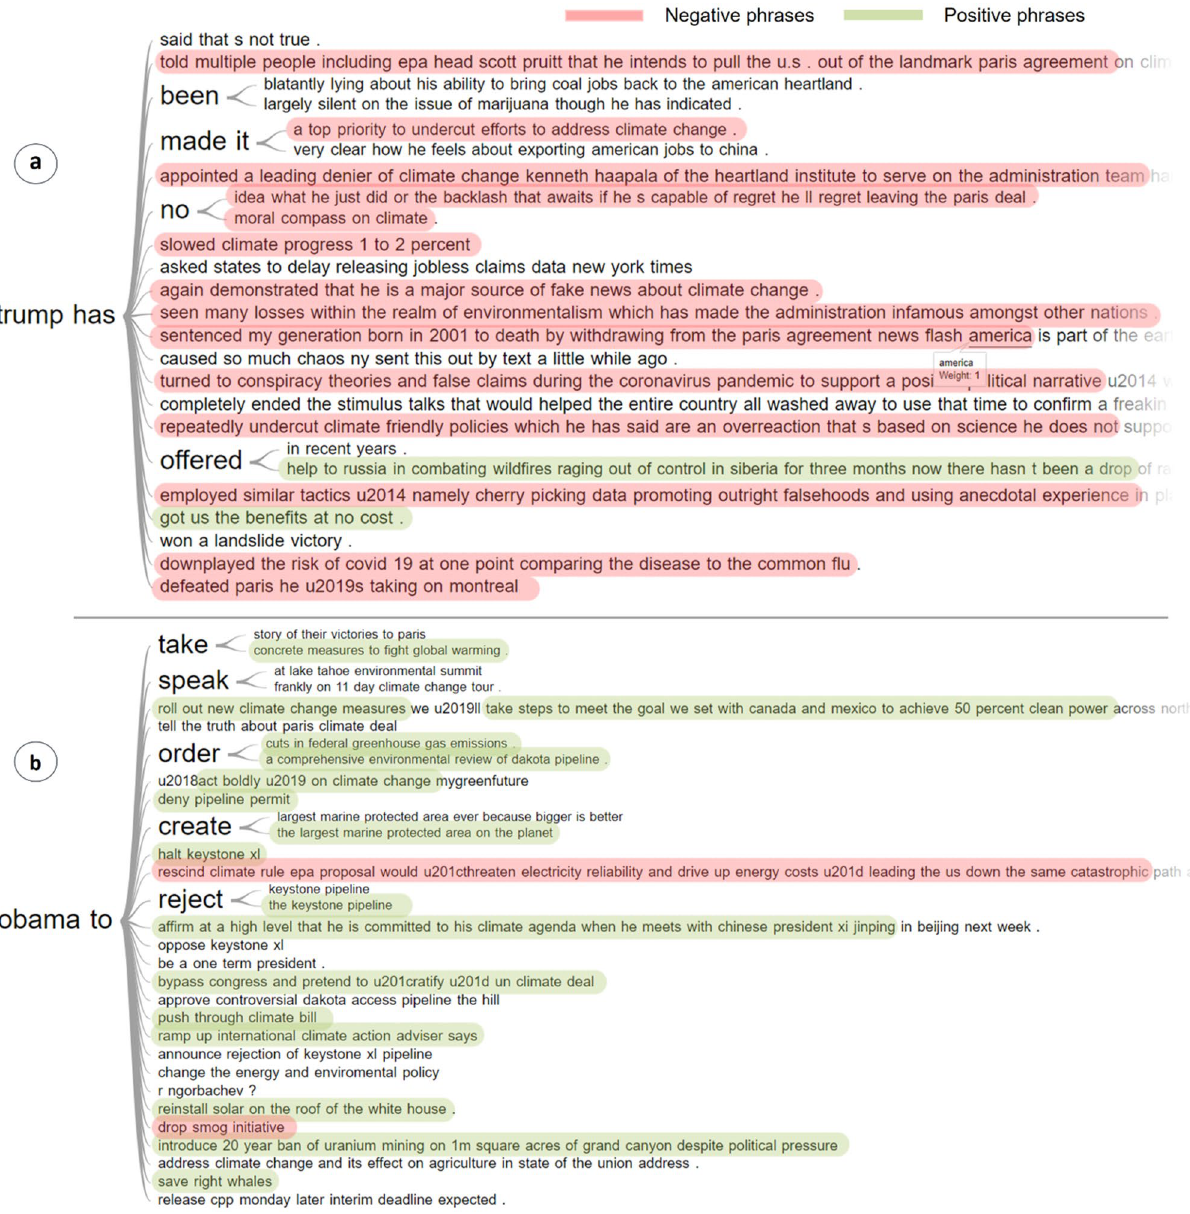
Figure 12. Word trees generated from the Administration cluster comparing a set of random phrases from discussions related to the former US presidents—Donald Trump and Barack Obama. The phrases with positive sentiments are highlighted with green colour and the phrases with negative sentiments are highlighted with red. A stark contrast can be observed in the expressed sentiments of the Reddit users when comparing the discussions related to the former two US presidents. People sound highly dejected when it comes to discussions related to Donald Trump’s policies and actions on climate change, and so expressed mostly negative